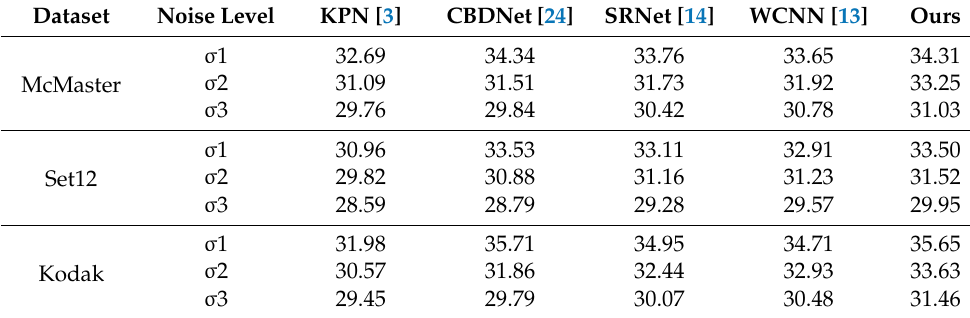
Table 3. The average PSNR(DB) results of different methods on three datasets.